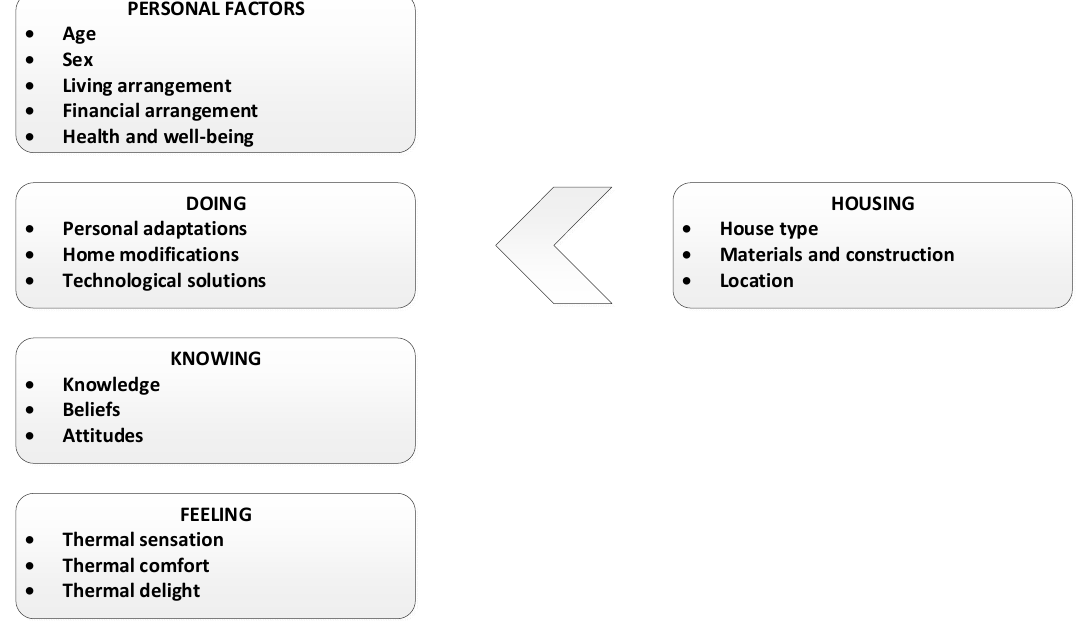
Figure 1. Factors important for understanding heating and cooling behaviours. Adapted from van Hoof et al. [26].